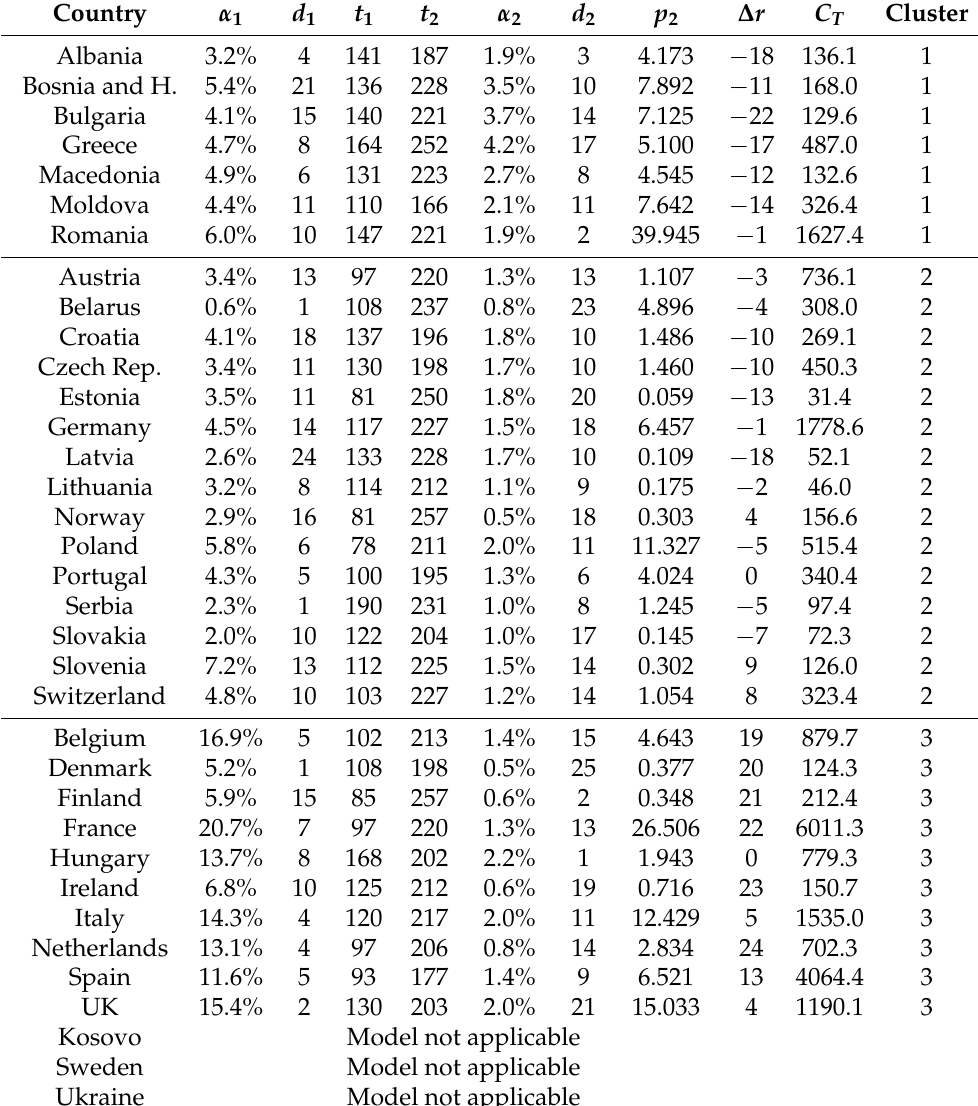
Table 1. Results of the time series analysis for 35 European countries. The first 7 columns contain the parameters of the time series model (Equation (1)): α 1 and α 2 = corrected case fatality rates of phase 1 and phase 3. d 1 and d 2 = shift parameters (days) of phase 1 and 3. Date of switch between phase 1 and phase 2: March 1 + t 1 (days). Date of switch between phase 2 and phase 3: March 1 + t 2 (days). p 2 = average deaths in phase 2. ∆ r = the difference of the α -ranks. C T = threshold value (Equation (3)). The last column contains the result of the cluster algorithm with three clusters. H. = Herzegovina.